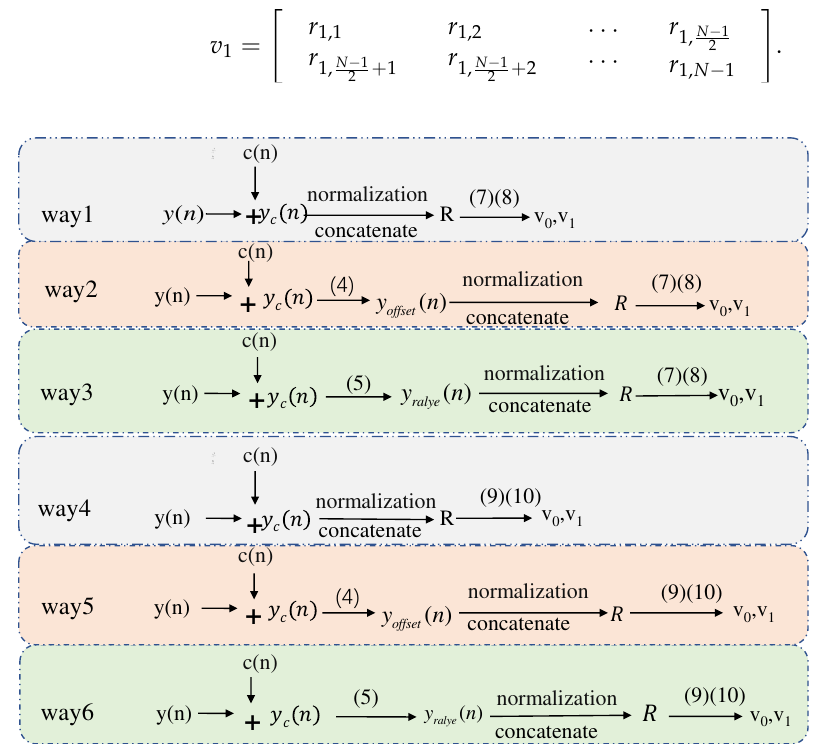
Figure 2. Six data augmentation